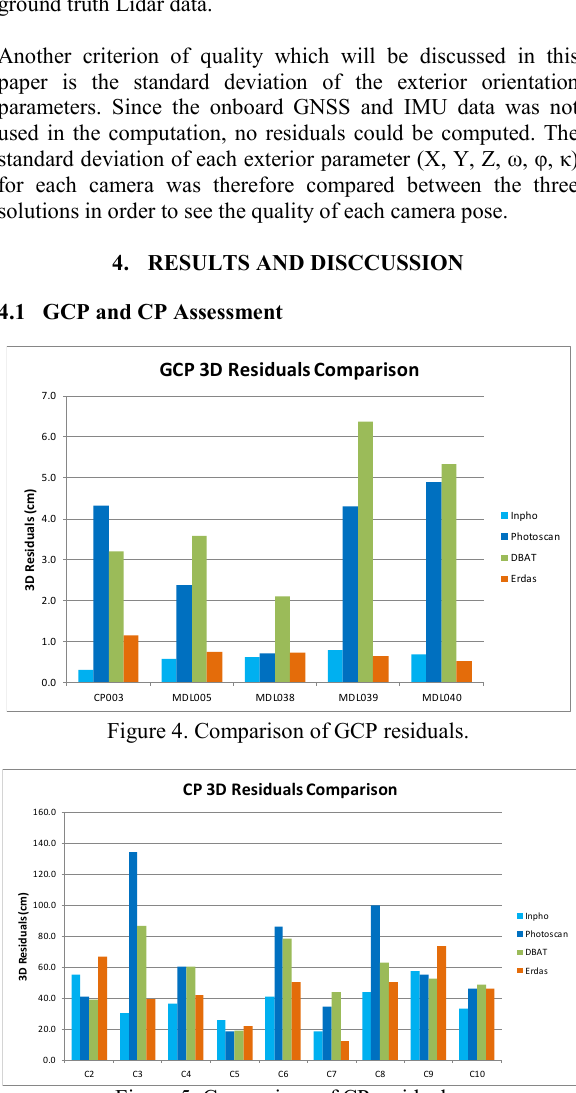
Figure 5. Comparison of CP